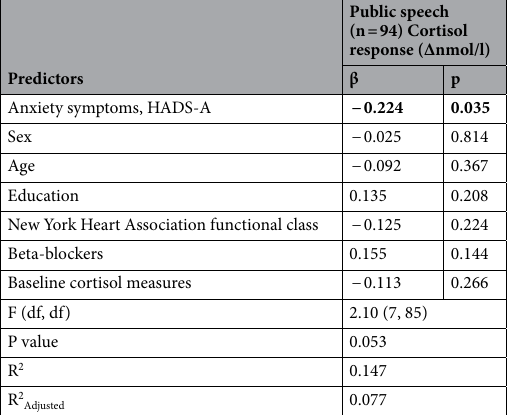
Table 3. Multivariable linear regression model, examining anxiety symptoms and its links with cortisol response to Trier Social Stress Test, while controlling for possible confounders. *Significant correlations ( p value < .05) in bold. HADS-A, Hospital Anxiety and Depression Scale.